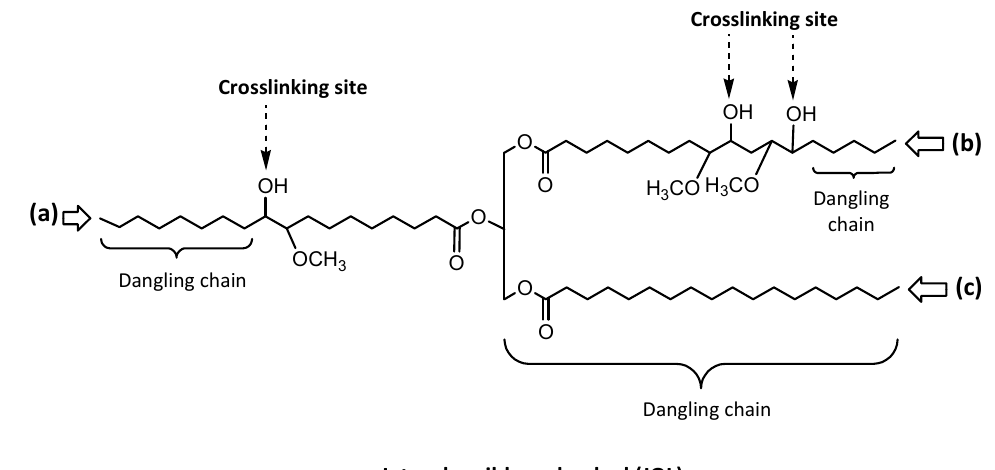
Figure 6. Position of reactive site at the fatty acid chain of polyol: ( a ) oleic acid, ( b ) linoleic acid, ( c ) stearic acid.